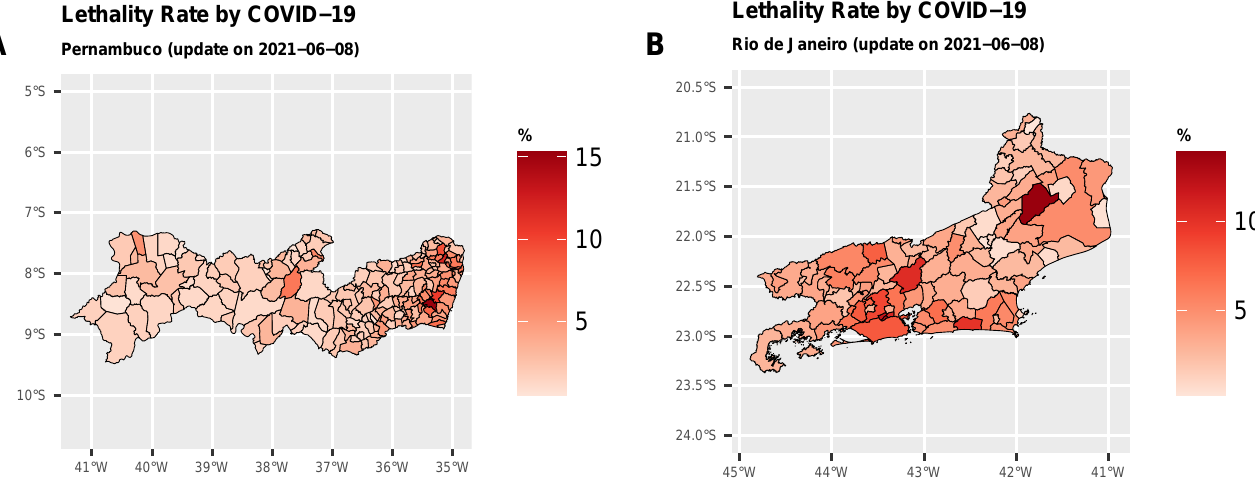
Figure 2. Map of the two states in Brazil with the highest lethality rate (%) (S are degrees South and W are degrees